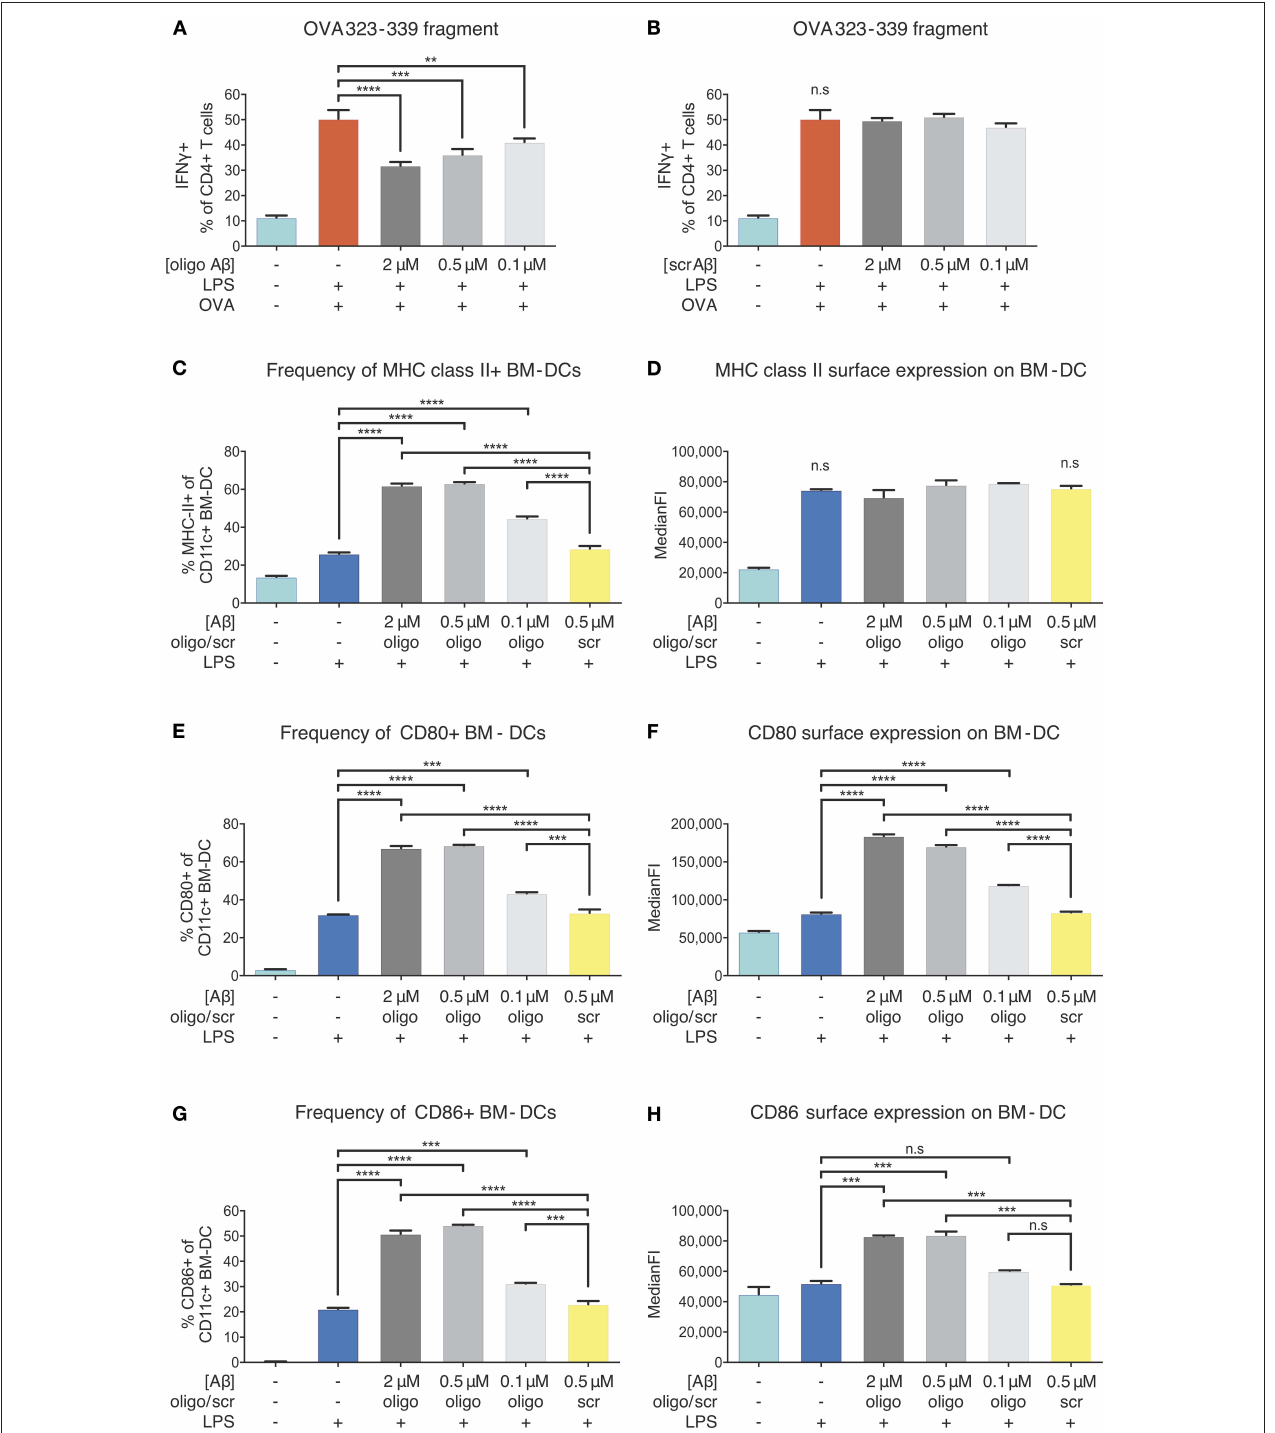
FIGURE 5 | Inhibition of APCs by A β 1-42 oligomers in vitro without involvement of antigen-processing and -presenting apparatus. The effect of A β 1-42 oligomers on antigen-processing was tested by using OVA 323-339, a fragment that leads to robust OT-II T-cell response without intracellular processing. Addition of A β 1-42 oligomers (A) , but not scrambled (scr) peptide (B) , inhibits T-cell activation in a dose-dependent manner, indicating that inhibitory effects of A β 1-42 oligomers are independent of APCs’ antigen-processing machinery. (C) Flow cytometry analysis of surface MHC-II expression shows that A β 1-42 oligomers (but not scr peptide) increase MHC-II + BM-DC frequencies. (D) In comparison with LPS-matured BM-DCs, no changes in surface MHC-II expression per cell (median fluorescent